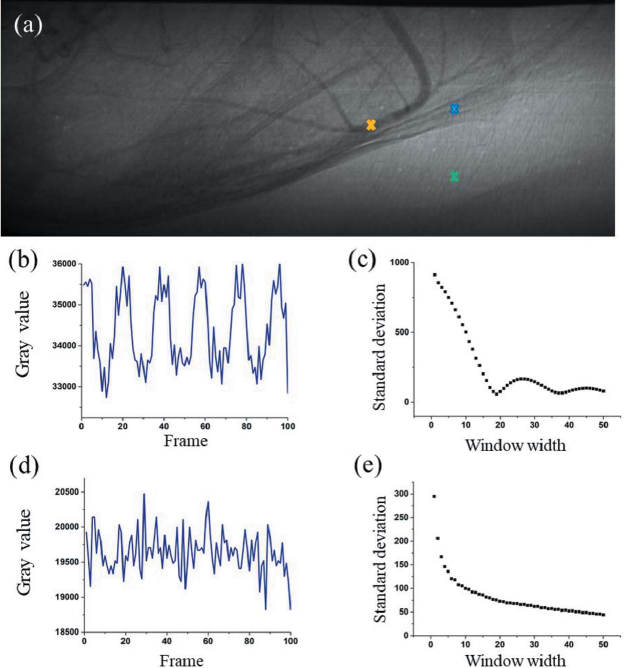
Figure 1 Standard deviation (SD) of signals introduced by tissue motion and background versus window width. ( a ) An original projection in the image sequence collected for angiography of the mouse brain. ( b ) Time- sequenced signal of tissue movements. ( c ) SD of tissue signal versus window width. ( d ) Time-sequenced signal of random noise. ( e ) SD of background noise signal versus window width.